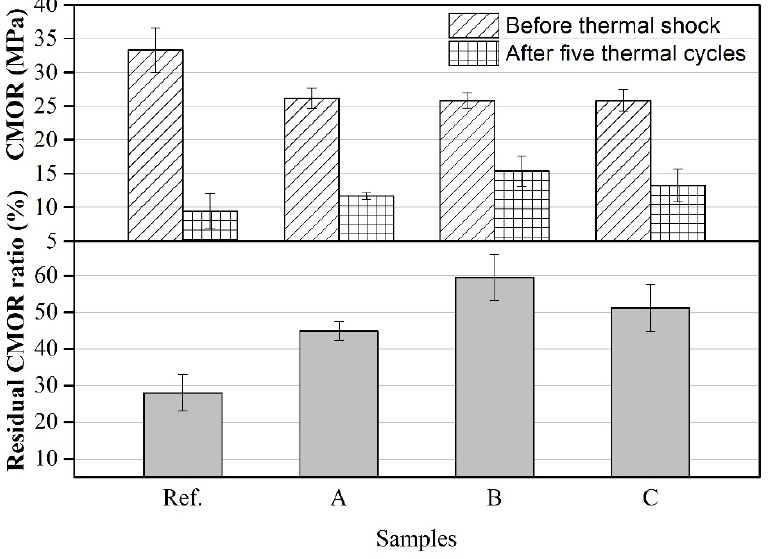
Figure 6. Variation of cold modulus of rupture (CMOR) and residual CMOR ratio of samples after 5 thermal cycles.